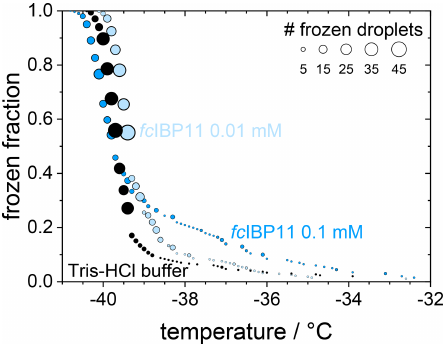
Figure 6. Cumulative frozen fractions as a function of tempera- ture of droplets containing fc IBP11 solutions with concentrations of 0.1mmolL − 1 (dark blue) and 0.01mmolL − 1 (light blue). The black circles show the freezing of the Tris-HCl buffer for reference. The circle area indicates the number of droplets frozen at a particu- lar